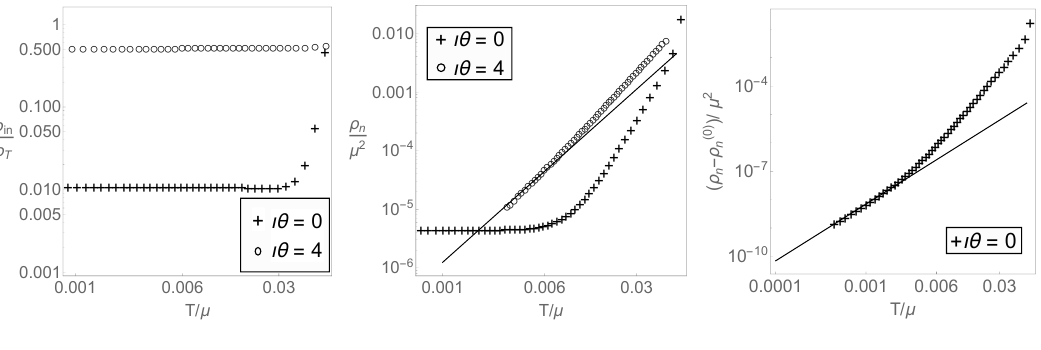
Figure 12 . An example using the potential in (C.38) with a = 5 so that z = 1 , θ = − 1 but ρ (0) (left). For ι = − 4 , we find that ρ n ∼ # T 2 whereas for ι = 0 , we find ρ n ∼ ρ (0) n + # T 2 (middle and